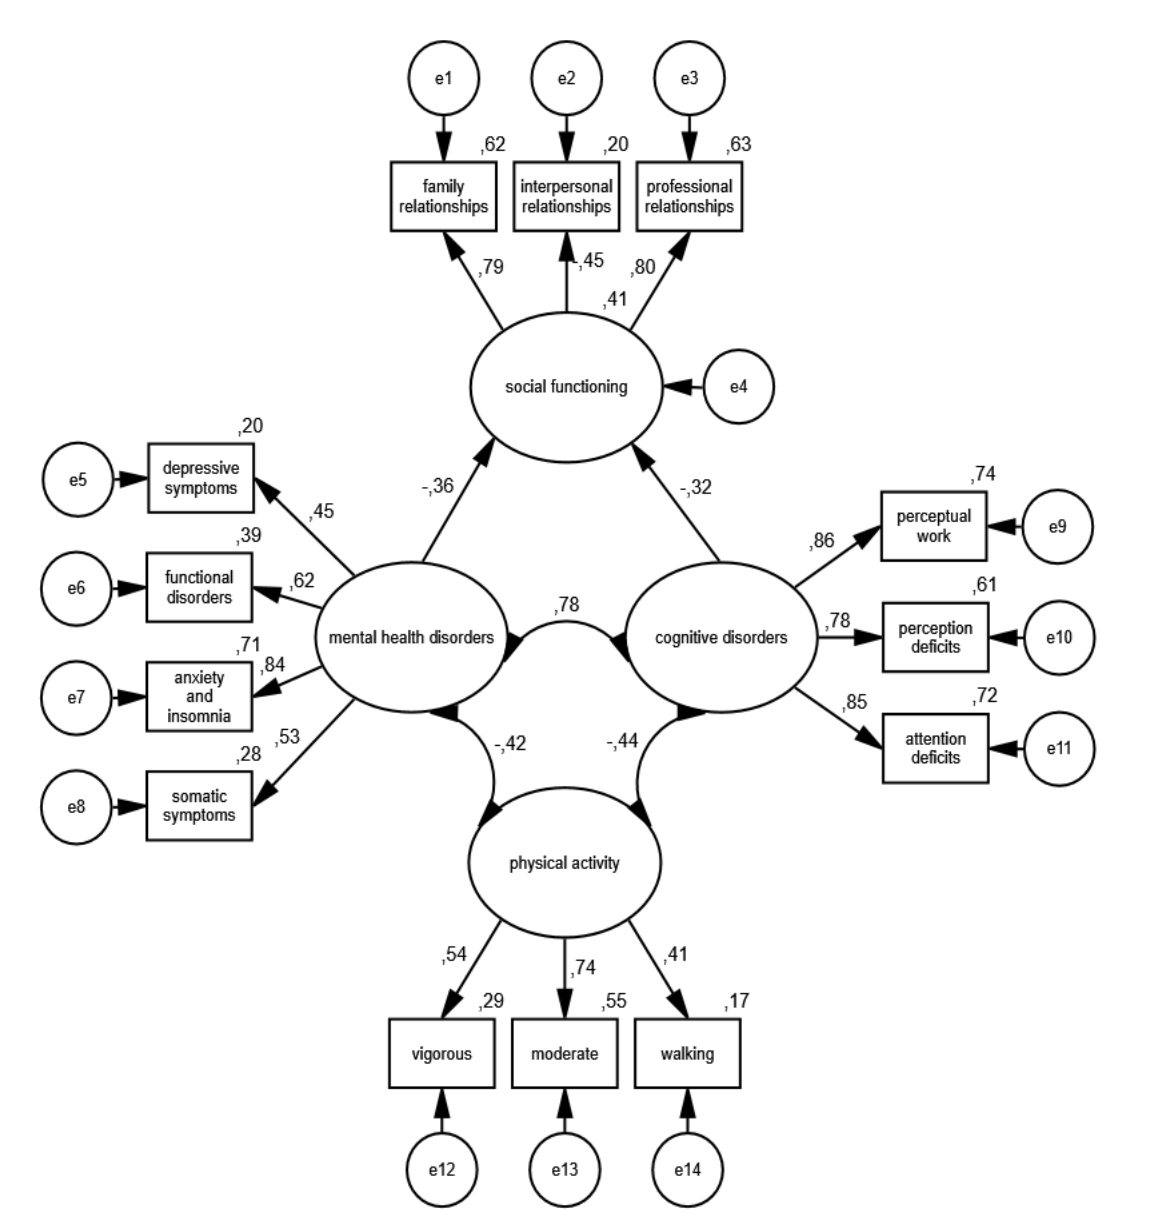
Figure 10. Standardized effects of the structural model of the relationship between physical activity and psychosocial functioning in a group of men .